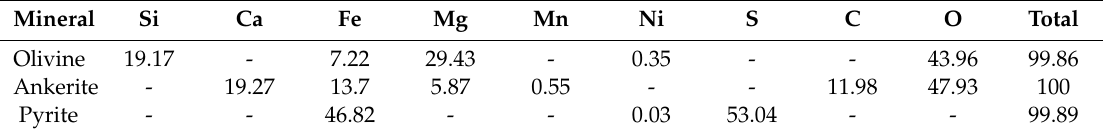
Table 1. Compositions of starting materials (wt. %).